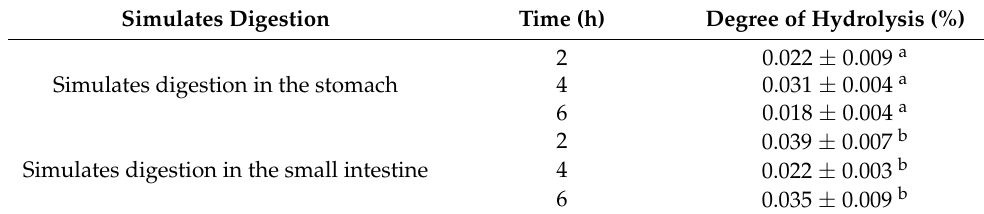
Simulates digestion in the small